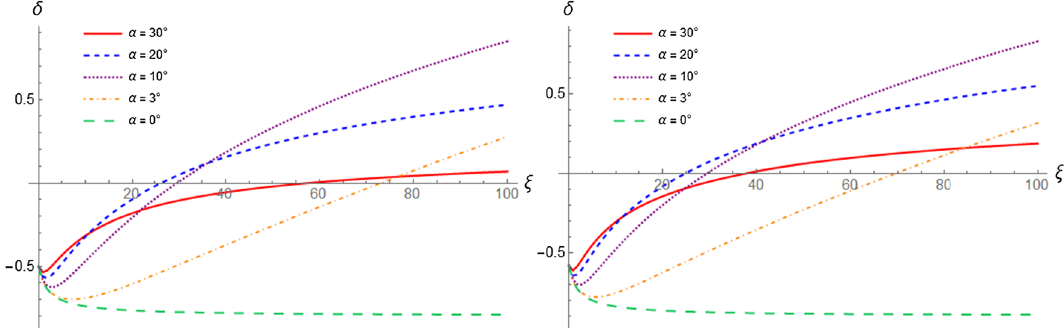
(solid), α = 2 ◦ (dashed), α = 1 ◦ 30 (cid:2) (dotted), α = 1 ◦ (dash-dotted) and α = 0 ◦ 30 (cid:2) (long dash) for σ = 5 (left) and σ = 10 (right)